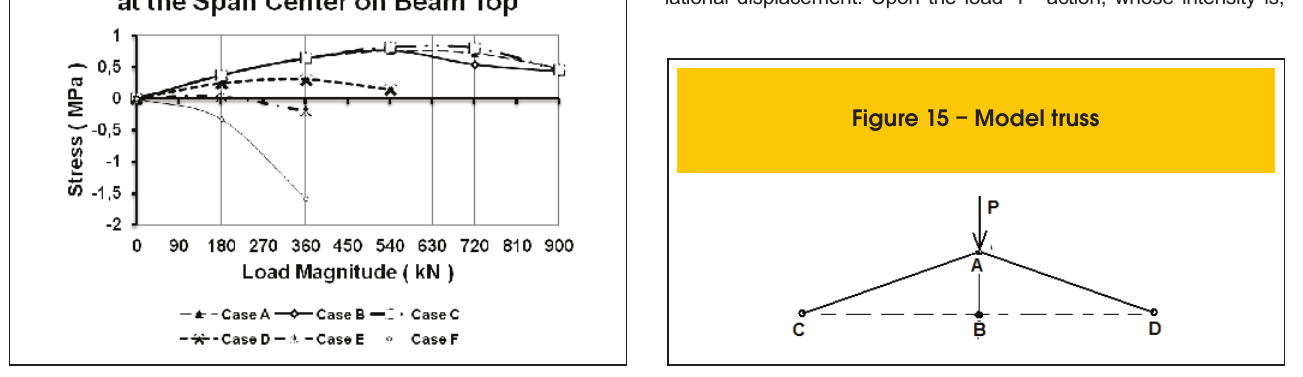
Figure 13 – Horizontal stress versus load at the span center section on beam top